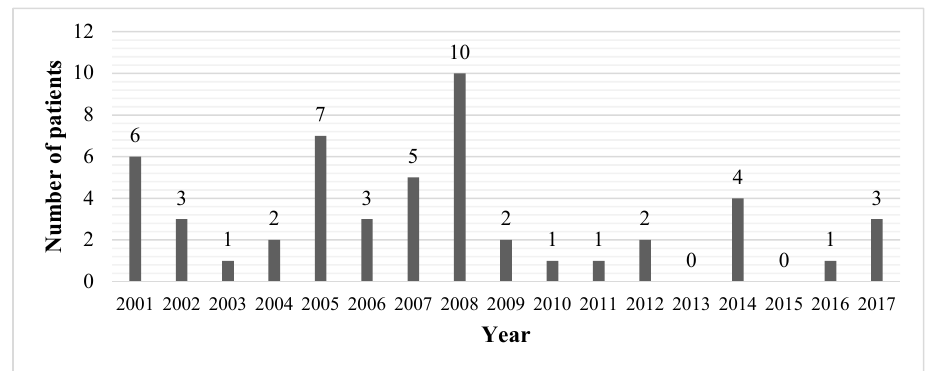
Figure 1. Annual distribution of presentations due to mushroom poisoning (N = 51).